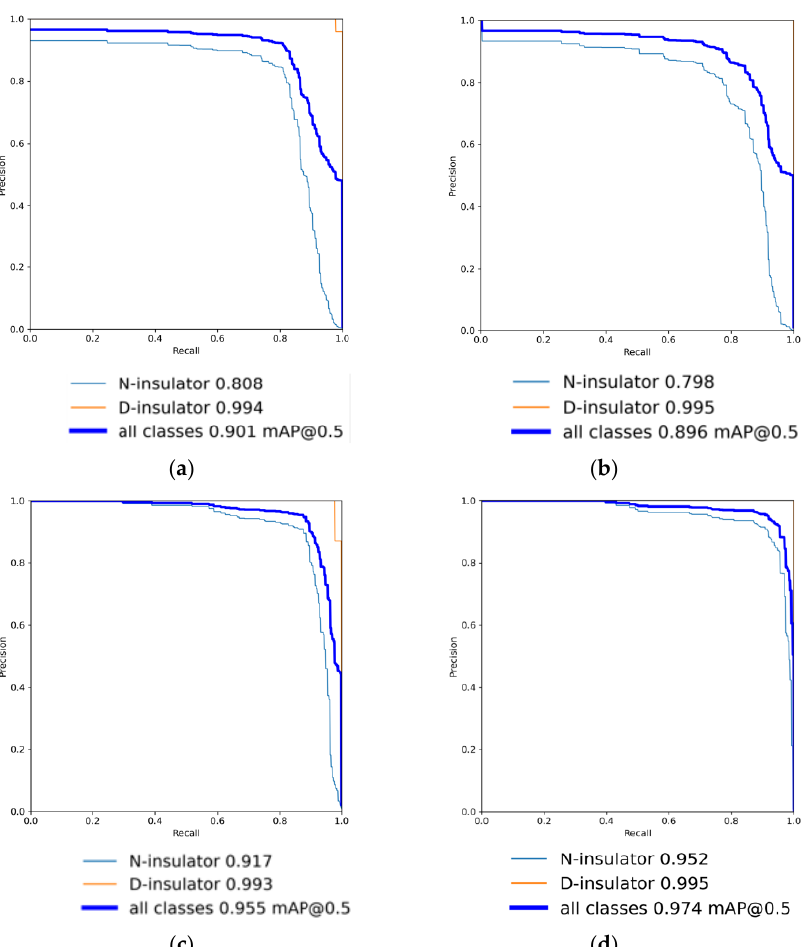
Figure 6. P-R curve. ( a ) P-R curve of method 1 in ablation experiment; ( b ) P-R curve of method 2 in ablation experiment; ( c ) P-R curve of method 3 in ablation experiment; ( d ) P-R curve of method 4 in ablation experiment.